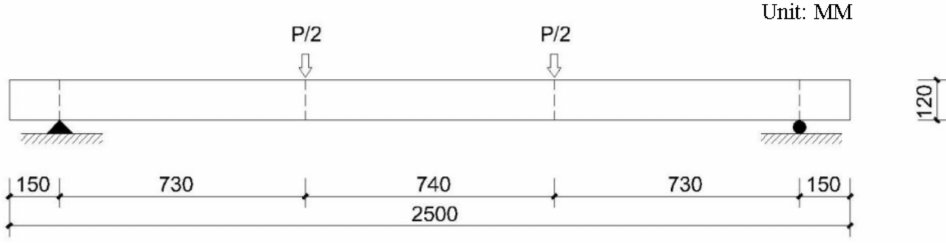
Figure 6. Loading